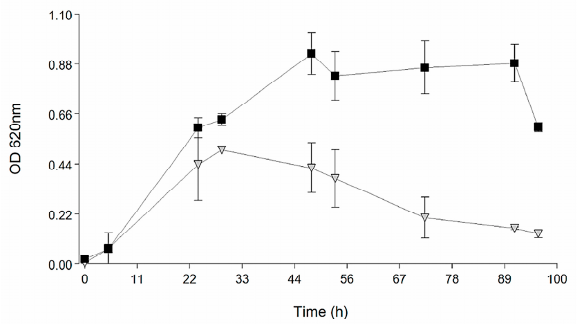
Figure 2. Growth curve for P. savastanoi pv. glycinea B076 in the presence of TEO. TEO ( ∇ ): 2.9 mg/mL; C ( (cid:4) ): control. The results are expressed as the mean ± standard error (SEM) of the OD measured at 620 nm. Means with different letters indicate statistically significant differences ( p < 0.05). Lowercase letters compare the control (0 mg/mL) and strain treated with TEO. In all cases, significant differences with respect to the control were determined using the Kruskal–Wallis test ( p ≤ 0.05).